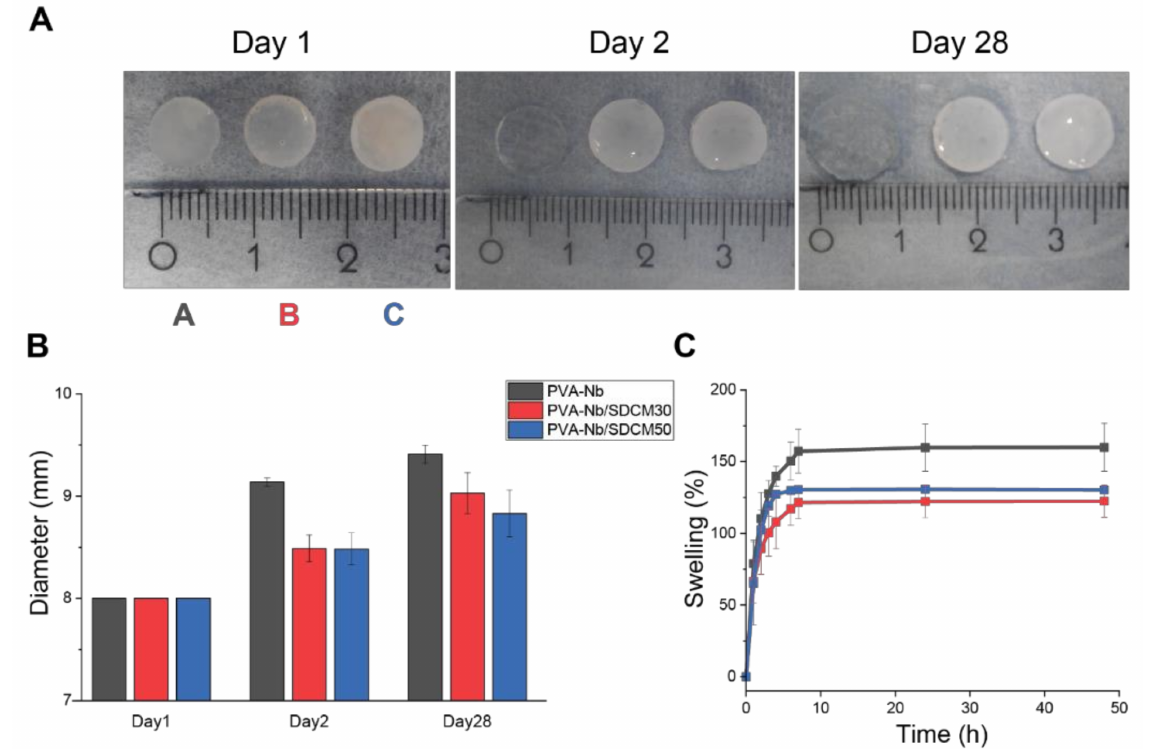
Figure 4. Swelling of norbornene-based hydrogels in phosphate-buffered saline (PBS). ( A ) The photograph of the hy- drogels 0, 2, and 28 days after cross-linking and soaking in PBS at 37 ◦ C. Morphology of PVA-Nb hydrogel (10 % wt/vol) cross-linked with 0.5 equivalent of thiol 2,2 (cid:48) -(Ethylenedioxy)diethanethiol (DT) and 2 mM lithium phenyl-2,4,6- trimethylbenzoylphosphinate (LAP). ( A ) PVA-Nb, ( B ) PVA-Nb/SDCM30, and ( C ) PVA-Nb/SDCM50 were successfully cross-linked into hydrogels. ( B ) The sizes of the hydrogels over the course of the 28-day experiment and the ( C ) swelling percentages are presented over the course of 48 h incubation in PBS.